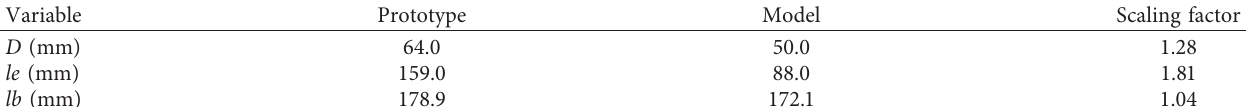
Table 2: Geometric parameters and scaling factors of the prototype and scaling model.